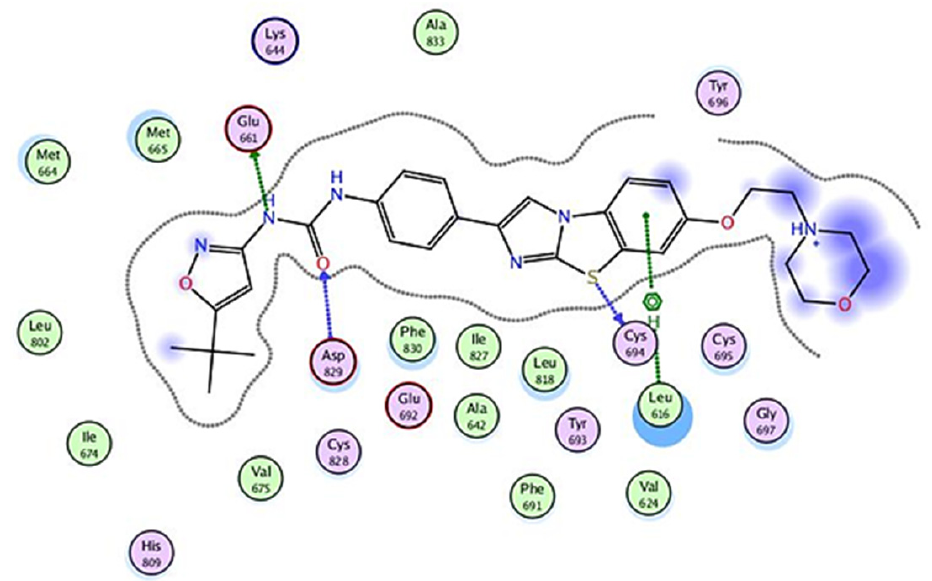
Figure 6. P30-re-docked ligand 2D interactions inside the active site of FLT3 receptor.